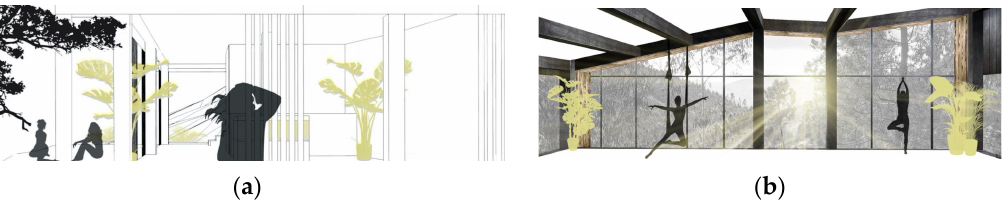
Figure 8. Tri Shala’s atmosphere (second dimension of the design). ( a ) Tri Shala’s forest stems (ground floor) (Source: compiled by the author); ( b ) Tri Shala’s forest crown (first floor) (Source: compiled by the author).